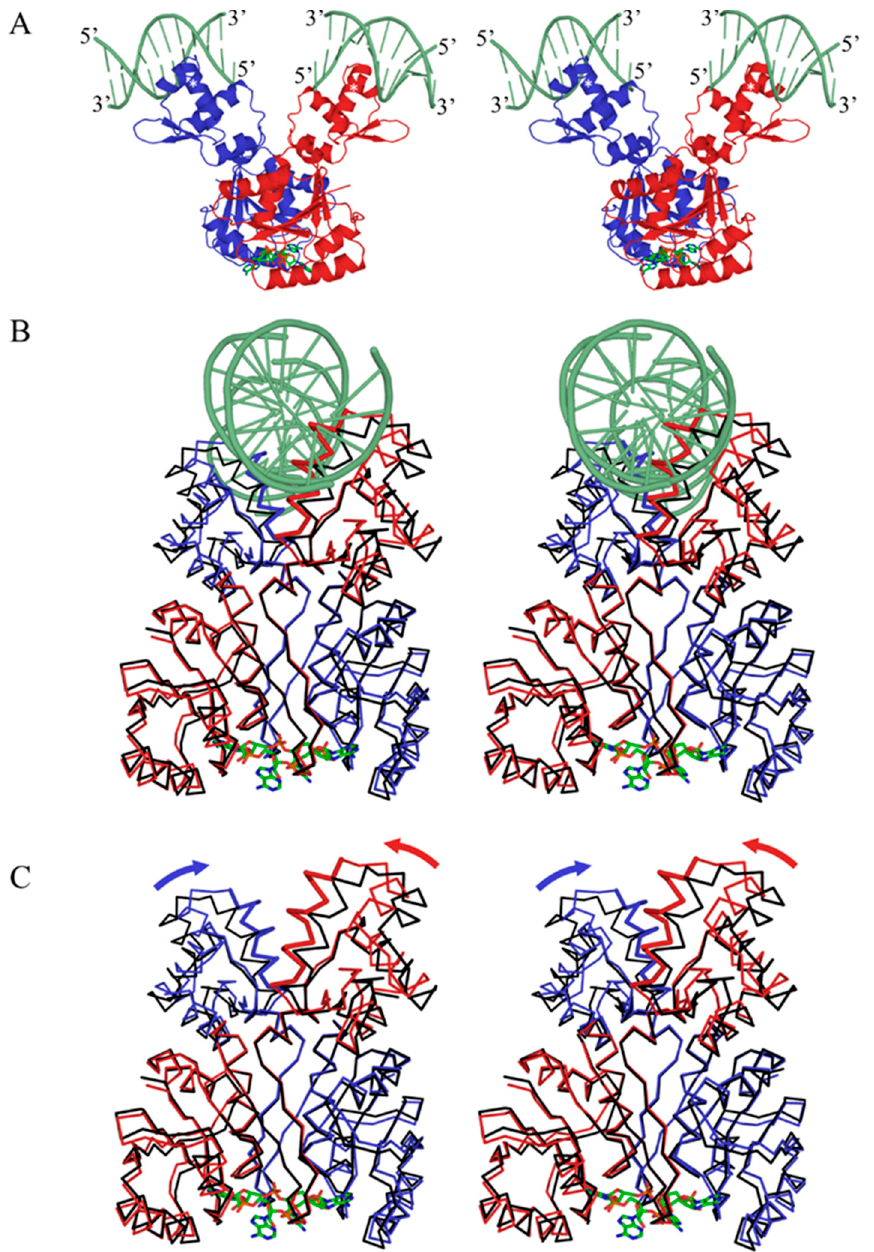
Figure 5. cA 4 -induced conformational changes. ( A ) Divergent stereo image of the Csa3a/cA4 complex docked to DNA (light green) by superposition of individual wHTH domains onto B. subtilis OhrR (PDB code: 1Z9C [47]) (RMSD: 1.7 Å). We were unable to superposition the Csa3a dimer onto a single strand of B-form DNA, suggesting further conformational changes in Csa3a or DNA bending might occur. ( B ) Significant movement of the wHTH domains is seen at the putative protein/DNA interface in the Csa3a/cA 4 complex (blue and red) relative to the unbound structure (black). ( C ) The rotation of the wHTH domains (direction emphasized by arrows) relative to the CARF domain is a result of modest conformational changes in the CARF